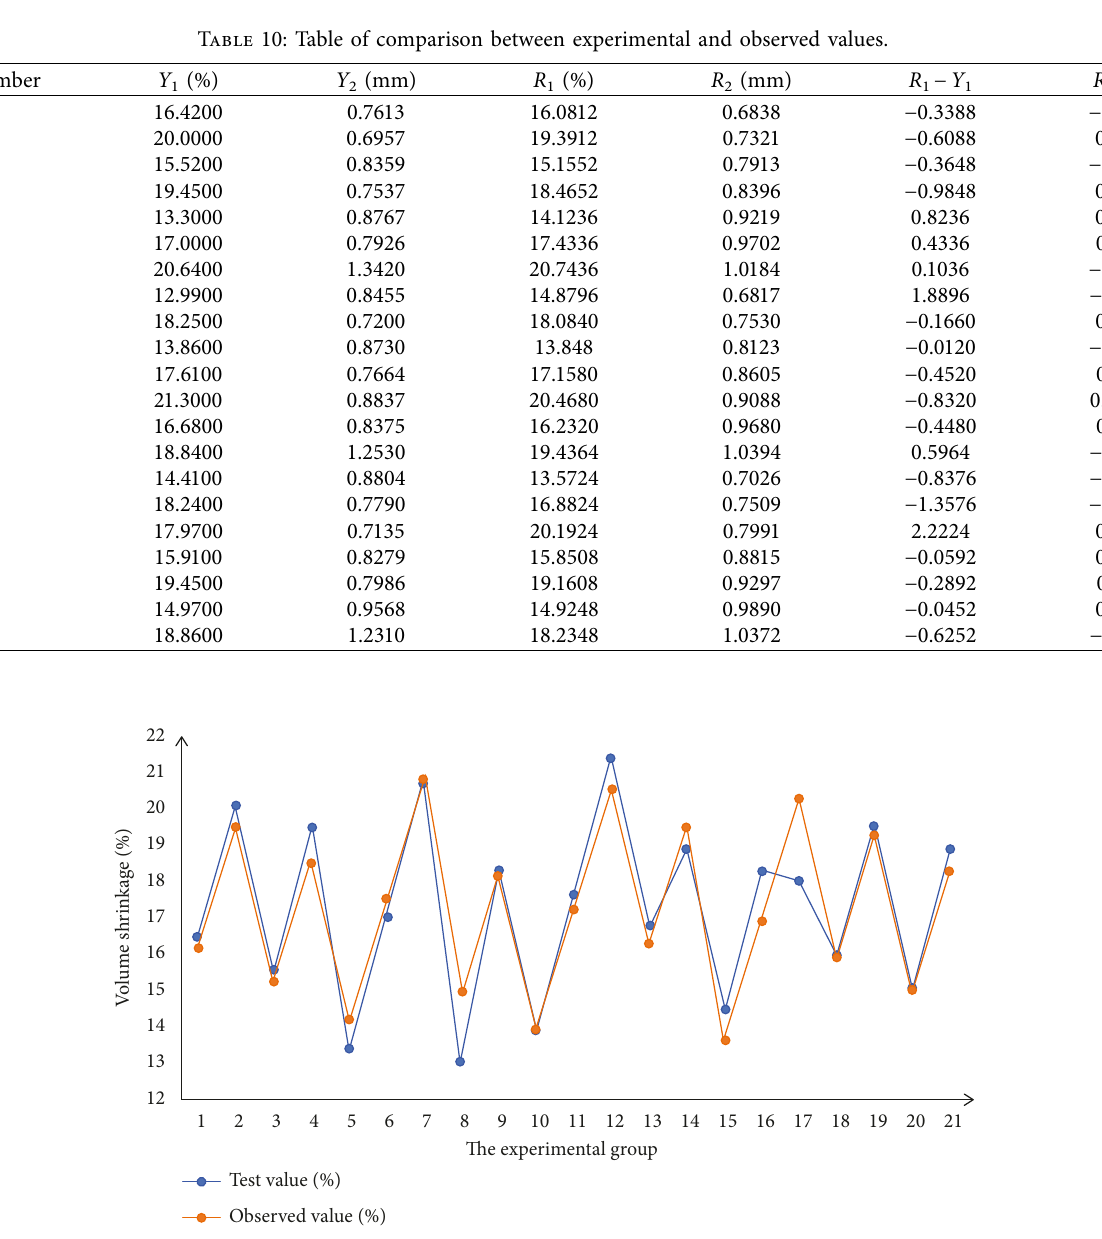
Figure 13: Comparison of experimental and observed volume shrinkage values.